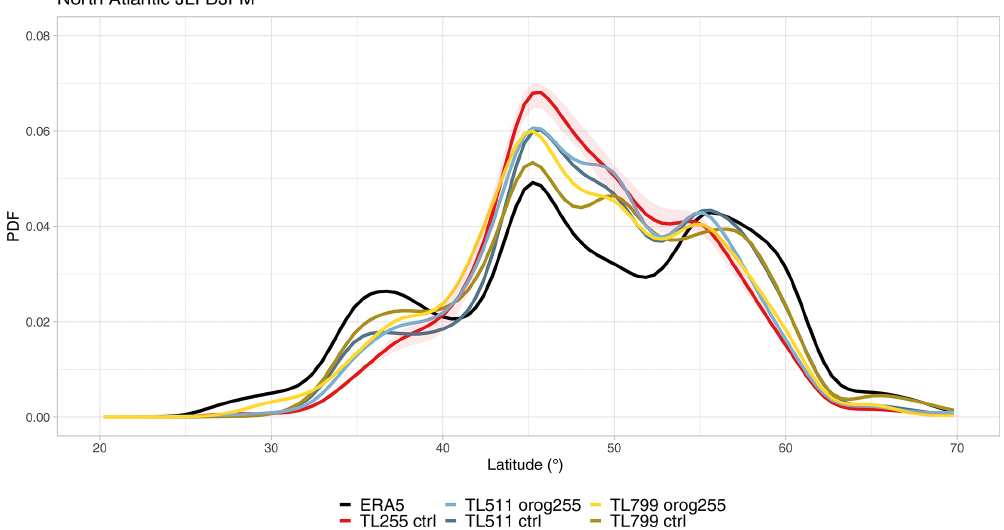
Figure 3. DJFM jet latitude index distribution for the different EC-Earth3 experiments, for ERA5 (black), TL255 (red), TL511 (blue) and TL799 (yellow). Lighter colours indicate orog255 experiments. For the TL255-ctrl run, the ribbons show the spread among the three integrations, with the ensemble mean in bold. Distributions are obtained from daily data by a kernel density estimation based on Gaussian smoothing with a bandwidth parameter of 1.25 ◦